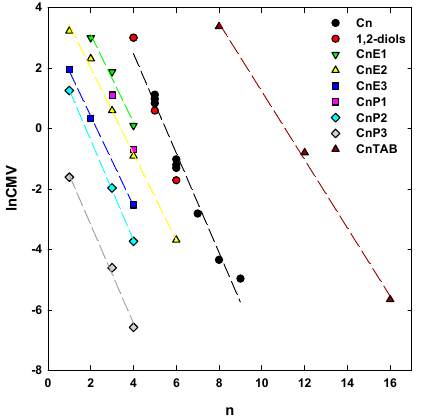
Figure 12. The effect of the number of carbons in alkyl chain ( n ) on CMV. Solids represent experiments, while lines show linear fitting curves.